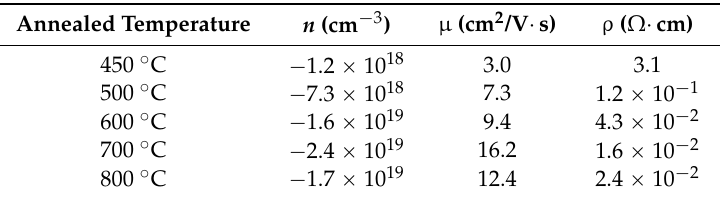
Figure 2. ( a ) X ‐ ray diffraction (XRD) patterns of n ‐ ZnO films annealed at 450, 700, and 800 °C, respectively, under vacuum atmosphere for 30 min and surface morphologies of ( b ) 700 °C ‐ and ( c ) 800 °C ‐ annealed n ‐ ZnO films. Table 1. Electrical properties of n ‐ ZnO films annealed at 450, 500, 600, 700, and 800 °C, respectively, under vacuum atmosphere for 30 min.